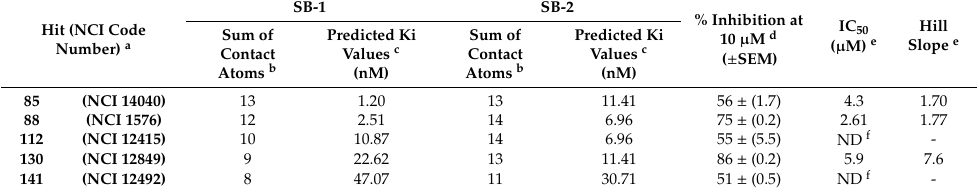
a Group of the highest-ranking hits obtainable from NCI (numbered 80–154) summarized in Table S3 and Figure S2 under Supplementary Material for structures, sum of contacts, predicted activity and % Inhibition at 10 µ M. b Contacts summations according to corresponding dbCICA model (Tables 1 and 2). c Predicted Ki by substituting the sum of contacts of each docked hit in the regression equation of corresponding dbCICA model. d Percentage inhibition determined for duplicate measurements at 10 µ M, standard error was calculated for duplicates at this concentration using functions of Microsoft excel software. e IC 50 and Hill slope values analyzed using GraphPad Prism software (version 7.03). Multiple concentrations range (0.1–100 µ M) used to determine IC 50 values each were conducted in duplicates, the standard error for each concentration used in IC 50 measurement are summarized in Supplementary Material Table S3. IC 50 was calculated using nonlinear regression of log (concentration) vs. inhibition % values plotted in Figure 5. f Not